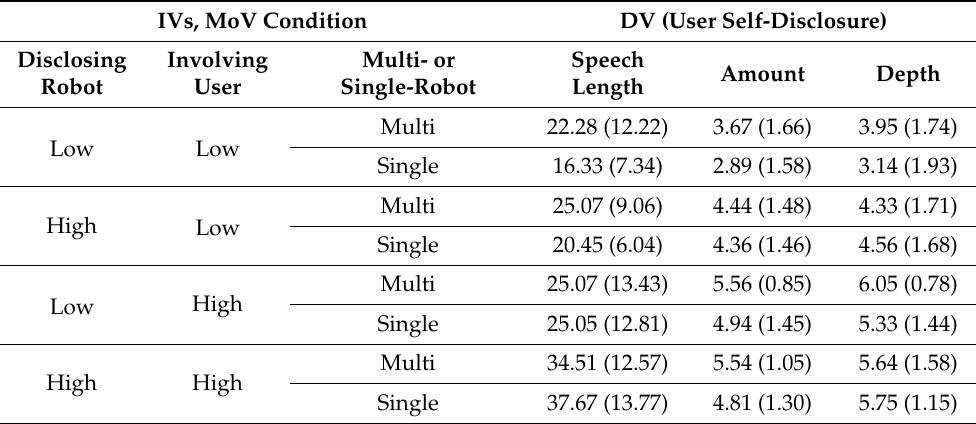
Table 3. Descriptive statistics for speech length, amount, and depth of user self-disclosure.